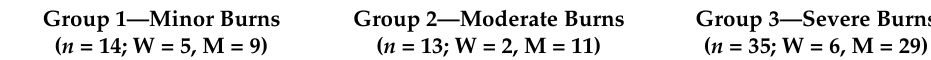
Table 1. Classification of burn severity (according to